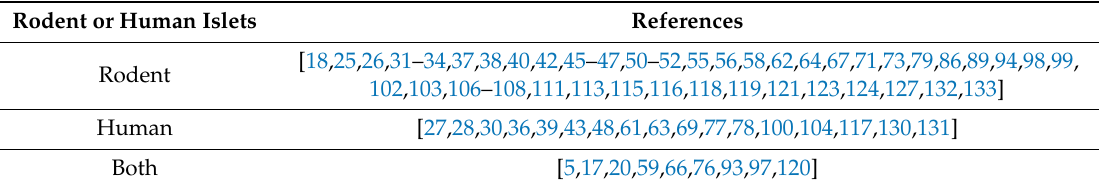
Table 3. References that studied the e ff ect of M1-like or M2-like macrophages on rodent islets, human islets, or both. Rodent or Human